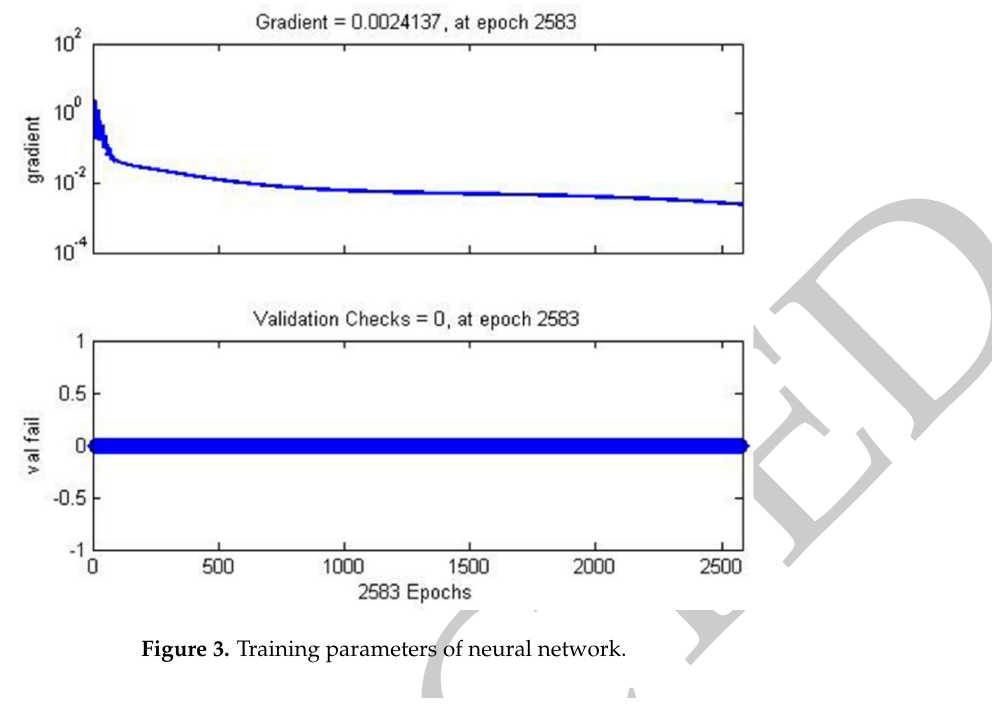
Figure 2. Effect of neural network training.